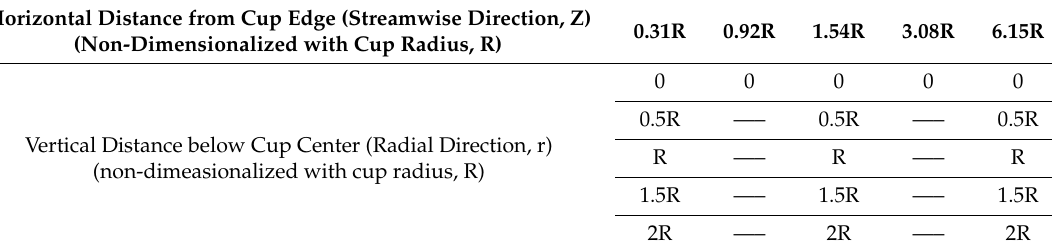
Table 1. The measurement locations inside the spray flow